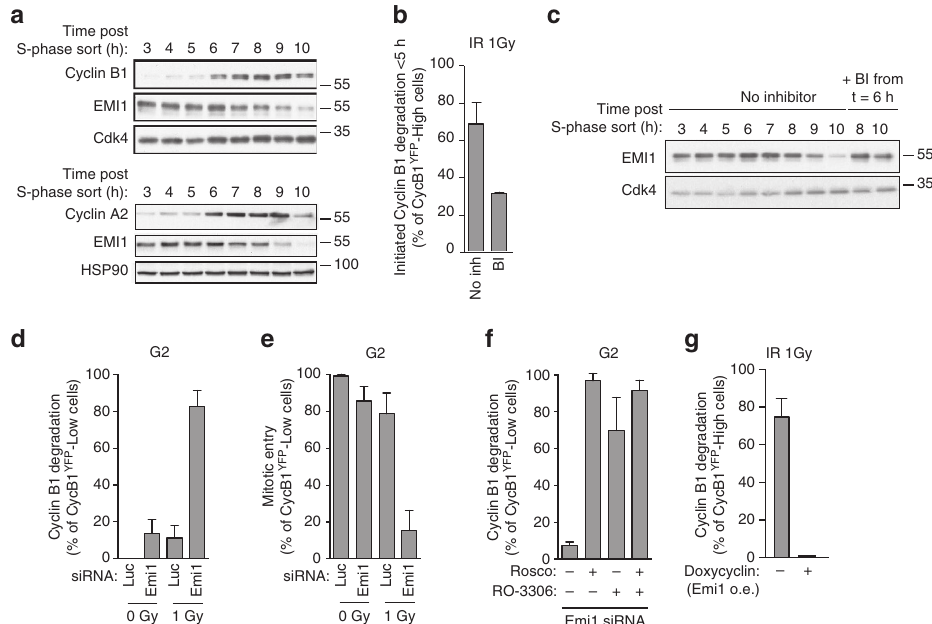
Figure 3 | Emi1 acts to maintain recovery competence in G2 cells. ( a ). Western blot showing EMI1, Cyclin A2 and Cyclin B1 protein levels at the indicated time following early-S phase sort. Representative blots of two independent experiments are shown. ( b ) Quantification of antephase cells (selected as in Fig. 2a) that started direct Cyclin B1 degradation within 5h from IR 1Gy. BI was added 2,5h before IR. Mean ± s.e.m. of three independent experiments. ( c ) Western blot showing Emi1 protein levels following early-S phase sort in the absence or presence of BI from 6h after the sort. ( d , e ) Cyclin B1 degradation ( d ) and mitotic entry ( e ) within 10h after 1Gy IR was analysed in RPE CCNB YFP G2 cells (selected as in Fig. 2c) partially depleted for EMI1. Mean ± s.d. of three independent experiments. ( f ) Cdk1 (RO-3306), Cdk2 (Roscovitine) or both were inhibited in undamaged RPE CCNB YFP cells partially depleted of EMI1. Direct Cyclin B1 degradation of cells in G2 phase at the moment of Cdk inhibition was analysed. Mean ± s.d. of three independent experiments. ( g ) EMI1 Turq overexpression was induced in RPE CCNB YFP cells 2h before IR 1Gy using doxycycline. Direct Cyclin B1 degradation was scored in antephase cells (selected as in Fig. 2a). Mean ± s.e.m. of three independent experiments. NATURE COMMUNICATIONS|7:12618|DOI: